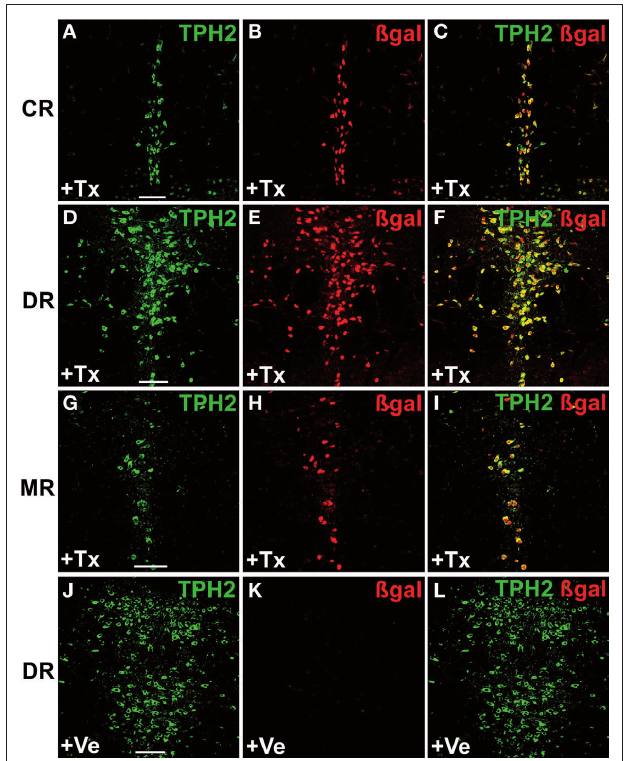
FIGURE 3 | Inducible recombination is restricted to serotonergic neurons of adult R26R TPH2-CreERT2 mice. R26R TPH2-CreERT2 mice of line 1.38 were injected with tamoxifen (1 mg twice daily) or vehicle for fi ve consecutive days starting at P90. Coronal sections show dual-label fl uorescence immunohistochemistry for TPH2 and β -gal in tamoxifen-treated ( + Tx) (A–I) and vehicle-treated mice ( + Ve) (J–L) . (A,D,G,J) TPH2 fl uorescence; (B,E,H,K) β -gal fl uorescence; (C,F,I,L) Merged images. Colocalization is visualized at the level of caudal raphe (CR) nuclei (A-C) , dorsal raphe (DR) nuclei (D-F,J-L) and median raphe nuclei (MR) (G-I) using confocal images. (C,F,I) In tamoxifen-treated mice there is extensive colocalization of β -gal and TPH2 indicating effi cient recombination. (J-L) Vehicle-treated mice show minimal colocalization demonstrating low background recombination without tamoxifen. Scale bars: 100 µm.